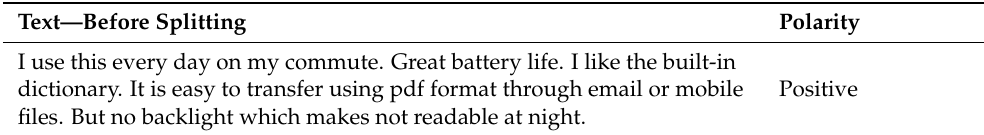
Table 1. Example sentence before splitting using punctuation and sentiment-analysis information. Text—Before Splitting